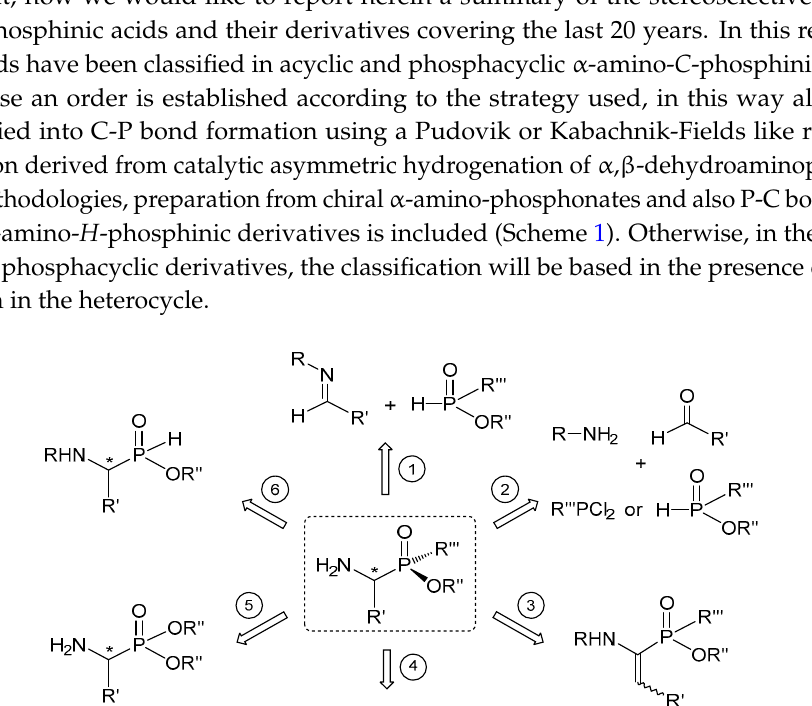
Figure 2. Similarity between the transition state of peptide hydrolysis and the α -amino- C -phosphinic motif. The additional interaction with the metal ion in the metalloproteases active site is